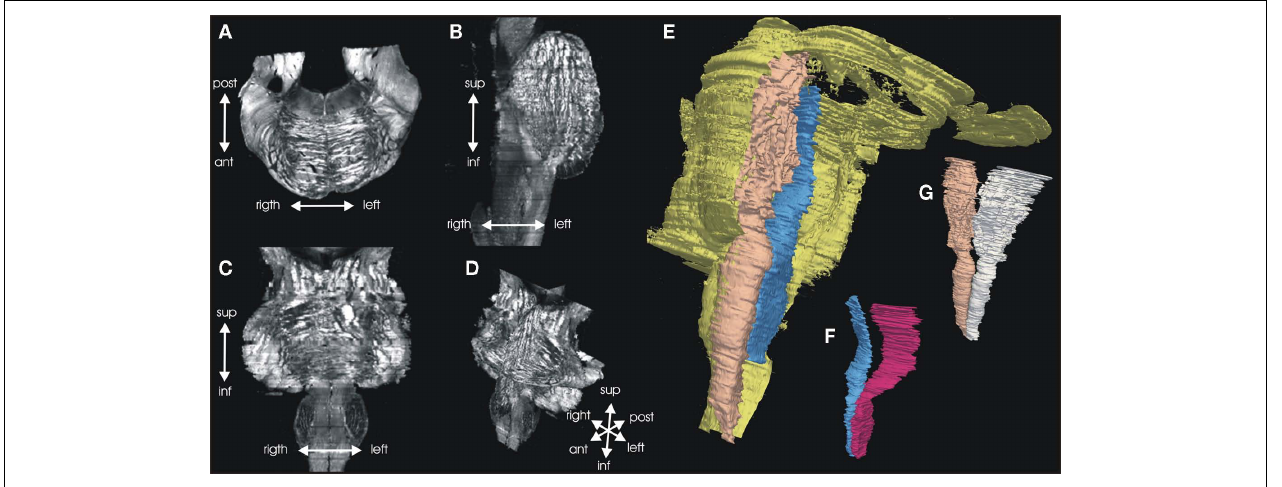
section through the 3D data set (D) shown as maximum intensity data. Pyramidal tract and lemniscus medialis were manually segmented, based on